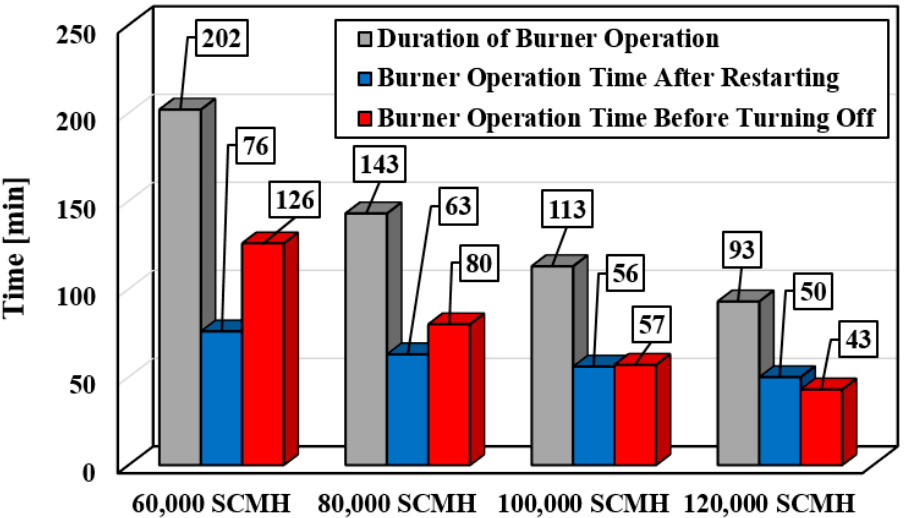
Figure 20. The burner operation time elapsed before turning it off, after restarting it, and the duration of the burner operation at various gas mass flow rates.